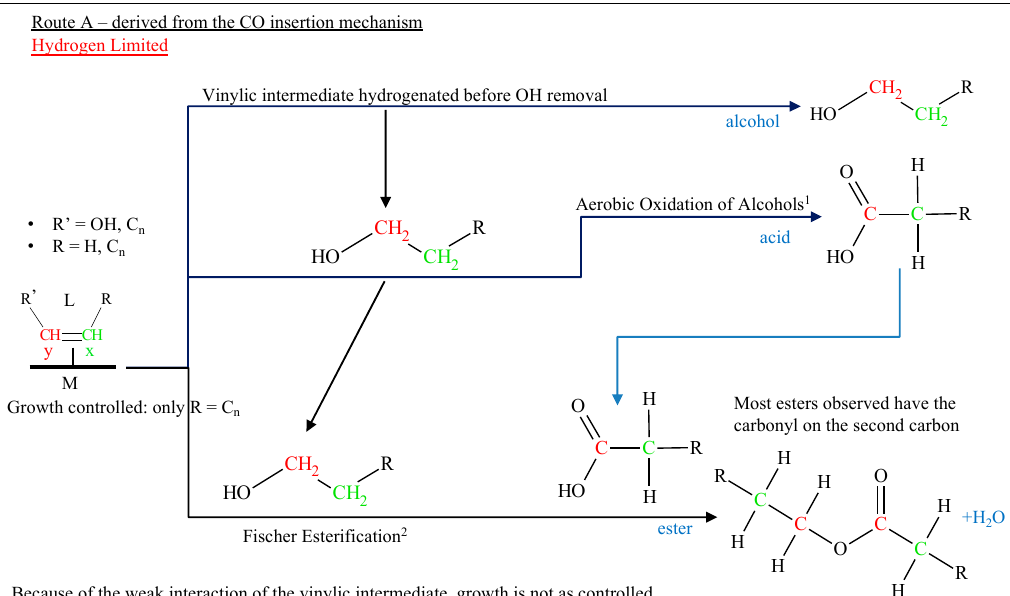
Figure 40. Taken from the previous route, where the vinylic intermediate takes on the L configuration, several products can be made because there is less controlled chain growth.